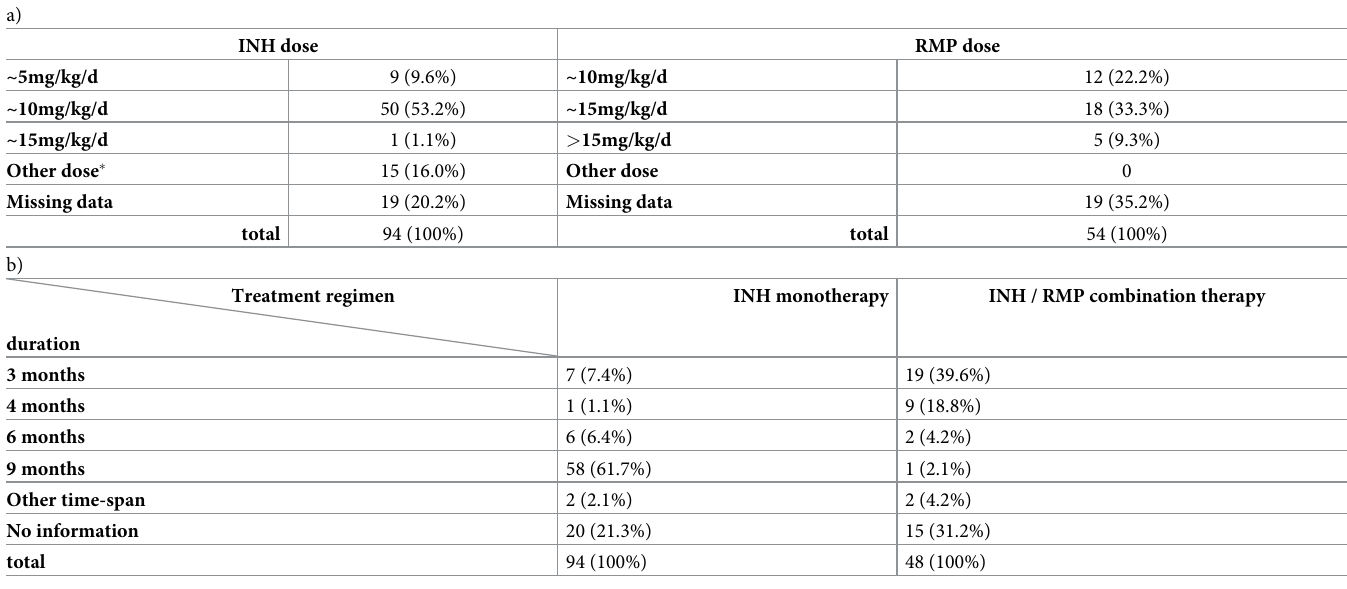
Table 3. Reported dose and duration of antituberculosis agents in LTBI